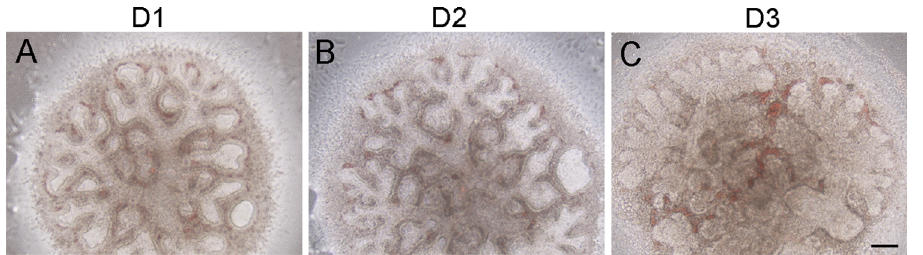
Figure 1. Morphogenesis of murine fetal distal lung explants in organ cultures. E15.5 WT lungs were diced and in vitro cultured. Microscopic analysis of explants at indicated time points. (A) day 1, (B) day 2 and (C) day 3. Scale bar, 100 m m.